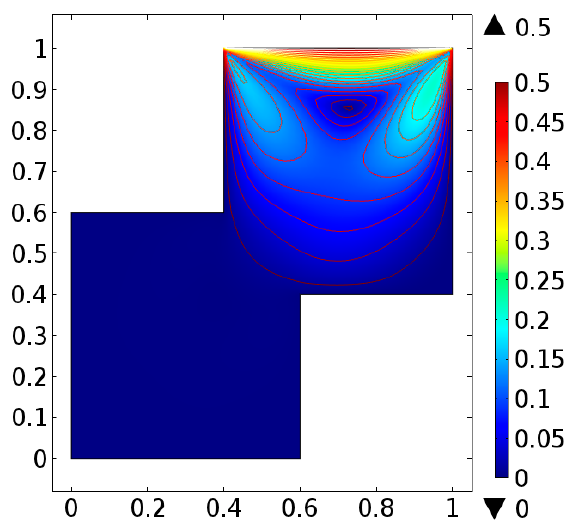
Figure 11. Velocity distribution at Re = 50 for case-I.